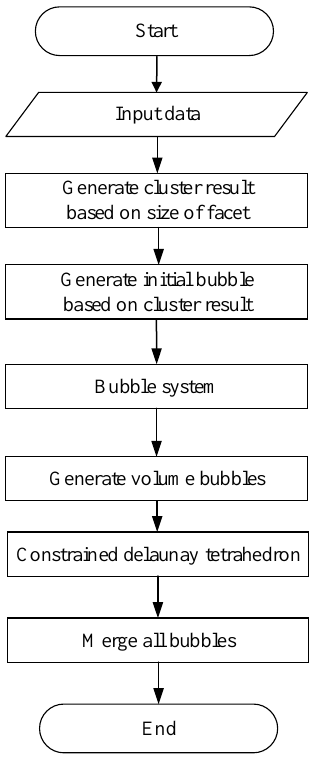
Figure 4. The workflow of the proposed bubble method.